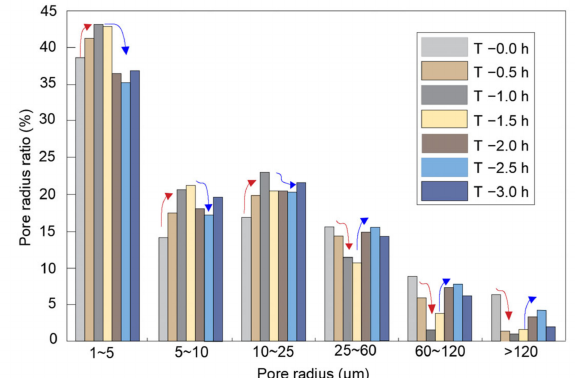
Figure 5. Histogram of pore size distributions of a (NH 4 ) 2 SO 4 solution-leached sample. The pores of the sample are divided into six sections according to the pore radius (1~5 µ m, 5~10 µ m, 10~25 µ m, 25~60 µ m, 60~120 µ m, and > 120 µ m). The data are acquired every 0.5 h, and the leaching time is 3